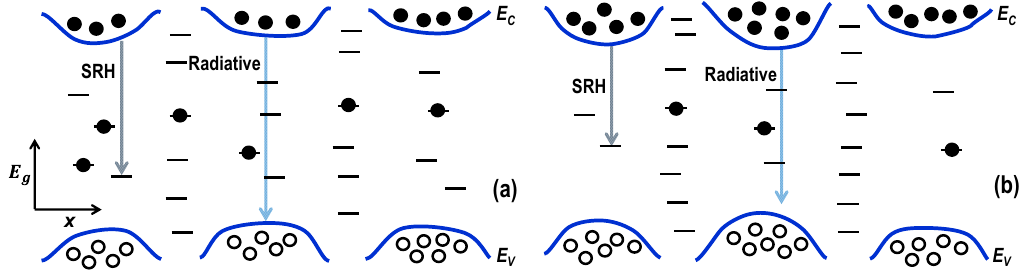
Figure 5. Schematic energy band diagram of the local in-plane potential fluctuation in the very small area of the QWs, where horizontal lines and filled (open) circles indicate the point defects and electrons (holes), respectively, with different levels of radiative and nonradiative recombination rates for samples ( a ) #1 and ( b ) #3.